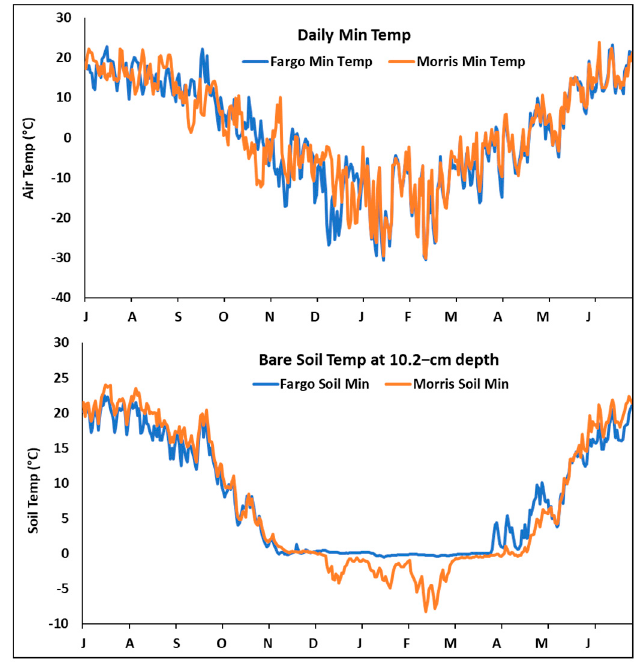
Figure 2. Comparison of minimum average daily air and soil temperatures (at 10.2 − cm depth) from July 2019 through June 2020 in Fargo, ND (https://ndawn.ndsu.nodak.edu, accessed on 31 January 2023) and Morris, MN (https://www.ars.usda.gov/midwest-area/morris-mn/soil-management-research/docs/weather/, accessed on 31 January 2023).